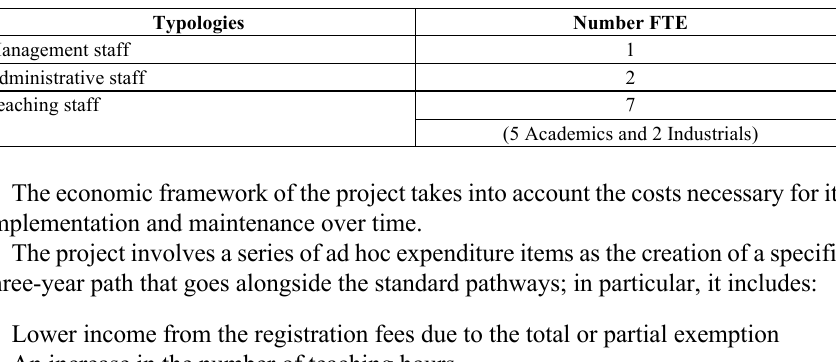
Table 4. Resource effort in term of Full-Time